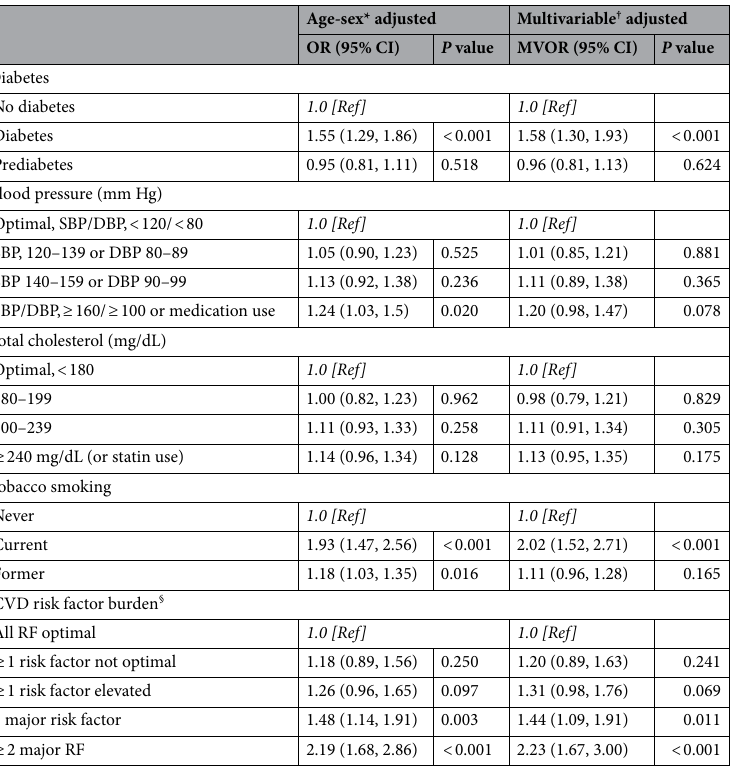
Table 3. Age-sex * and multivariable adjusted† odds ratios (95% CI) for hearing loss ‡ . Significant values are in italics. DBP diastolic blood pressure, MVOR multivariable adjusted odds ratio, SBP systolic blood pressure. *All CVD risk factors are covariates in individual risk factor models. † Adjusted for age, sex, noise exposure, hearing aid use, and BMI. Individual risk factors are covariates in individual risk factor models. ‡ Defined as PTA 0.5,1,2,4 > 20 dB HL in the worse ear. § Defined as per Table